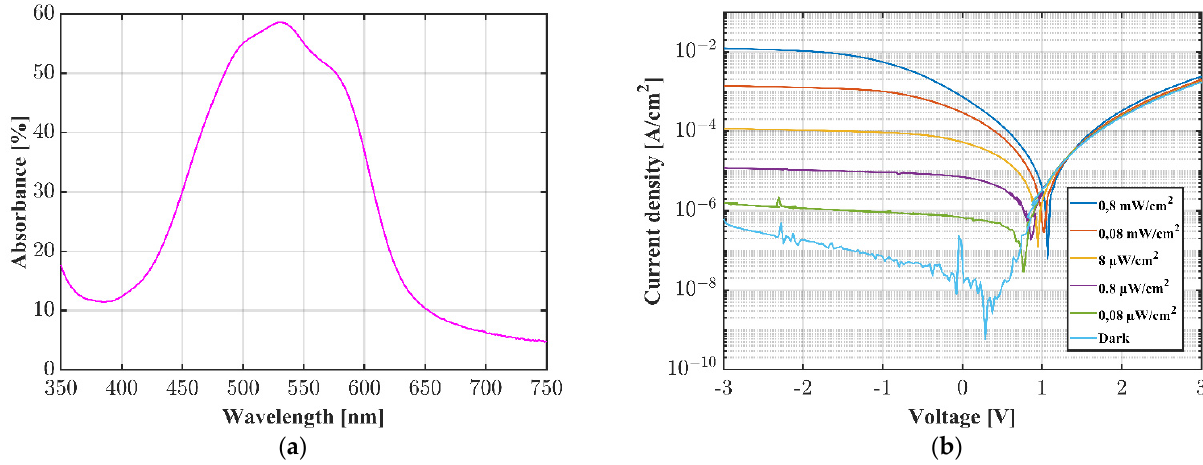
Figure 2. Optical and electrical characterization of the DMQA.DCV3T OPD. ( a ) UV-Vis measure- ment of 60 nm DMQA:DCV3T absorptive bilayer; ( b ) current density–voltage characteristics in the dark and under illumination with a subsequently filtered 520 nm laser.